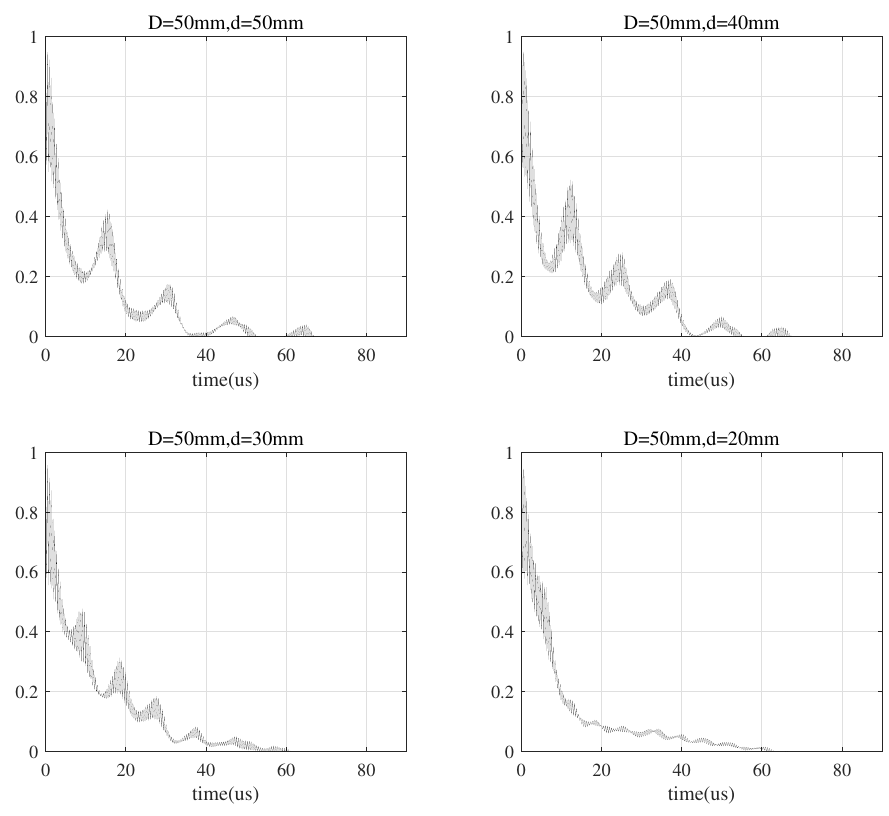
Figure 14. Multi-path intensity profile of the received signal by a transducer with diameter D = 50